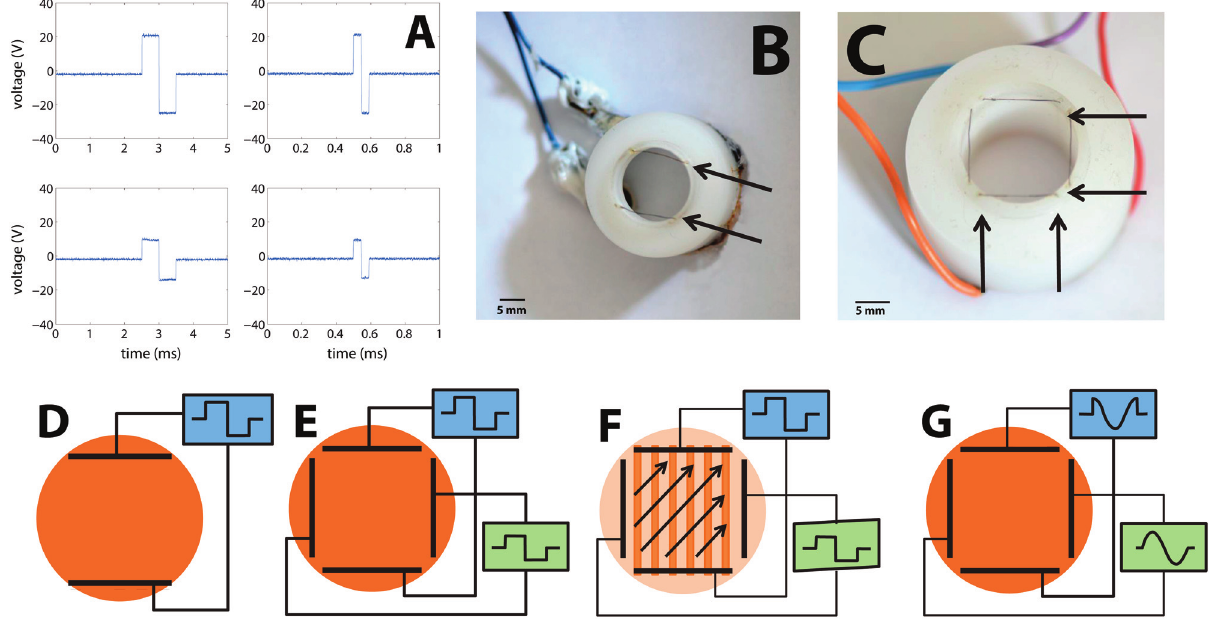
Fig 1. Apparatus used to stimulate neuronal cultures with external electric fields. (A) Waveforms of the measured applied voltage between the electrodes (upper row) and within the fluid (lower row), approximately at the center of the experimental cell where the culture is located. Left column is for pulse durations of 1ms and the right is for durations of 100 μ s. (B) The plastic insert with one pair of electrodes used to stimulate the neuronal culture. The electrode wires are indicated in the picture by arrows. A plastic rim extending into the medium locates the two parallel platinum wire electrodes about 1 mm above the culture. (C) The device used to stimulate the neuronal culture with two orthogonal pairs of electrodes. A plastic rim holds two pairs of platinum electrodes about 1mm above the culture, which are denoted in the picture by arrows. (D) Sketch of the electrical circuit for a pair of electrodes that is driven by a single square pulse with varying durations. The electric field created between these electrodes is used to stimulate a neuronal network cultured on a glass coverslip. (E, F) Sketch of the electrical circuit for two pairs of electrodes that are fed with separate single square pulses with varying durations (synchronized but with no common ground). Changing the relative amplitudes changes the orientation of the electrical field, which is used to directionally stimulate a neuronal network cultured on a cover slip. (G) Sketch of the electrical circuit for obtaining a rotating electric field. Two pairs of electrodes are each fed with one cycle of sine or of cosine voltage pulses (i.e. two signals with the same amplitude but phase shifted by π